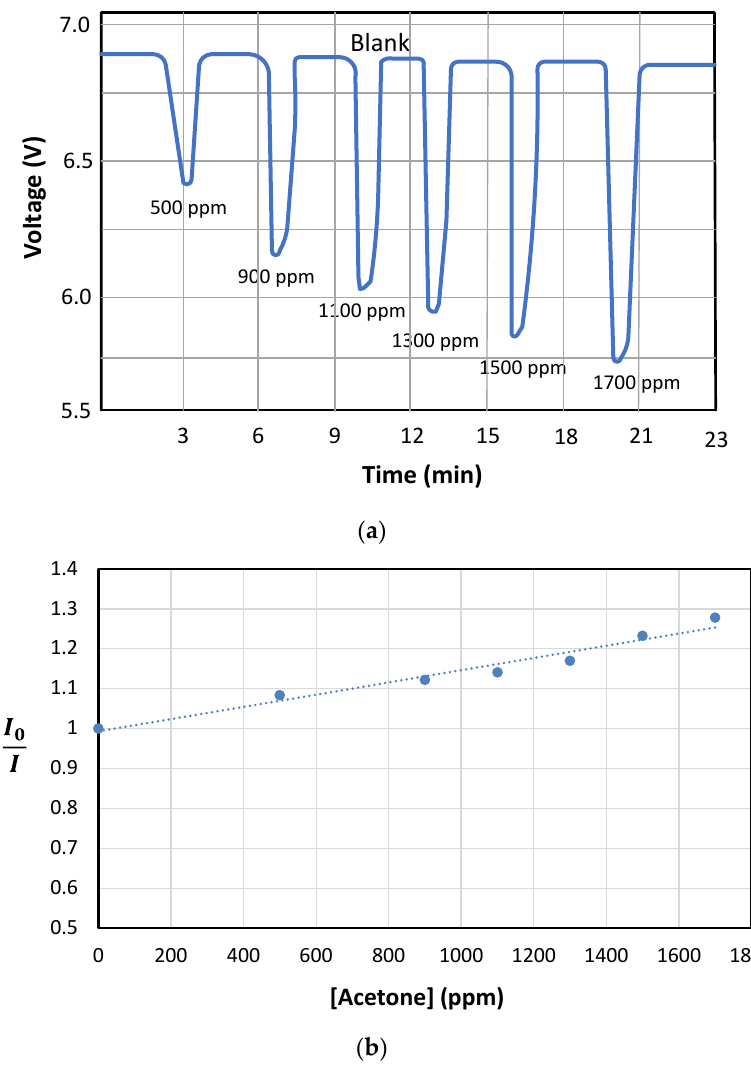
Figure 8. ( a ) The phosphorescent response of the sensing phase to increases in acetone concentrations in the gas flow. ( b ) Calibration curve using the Stern–Volmer equation, which typically governs photoluminescence quenching processes.